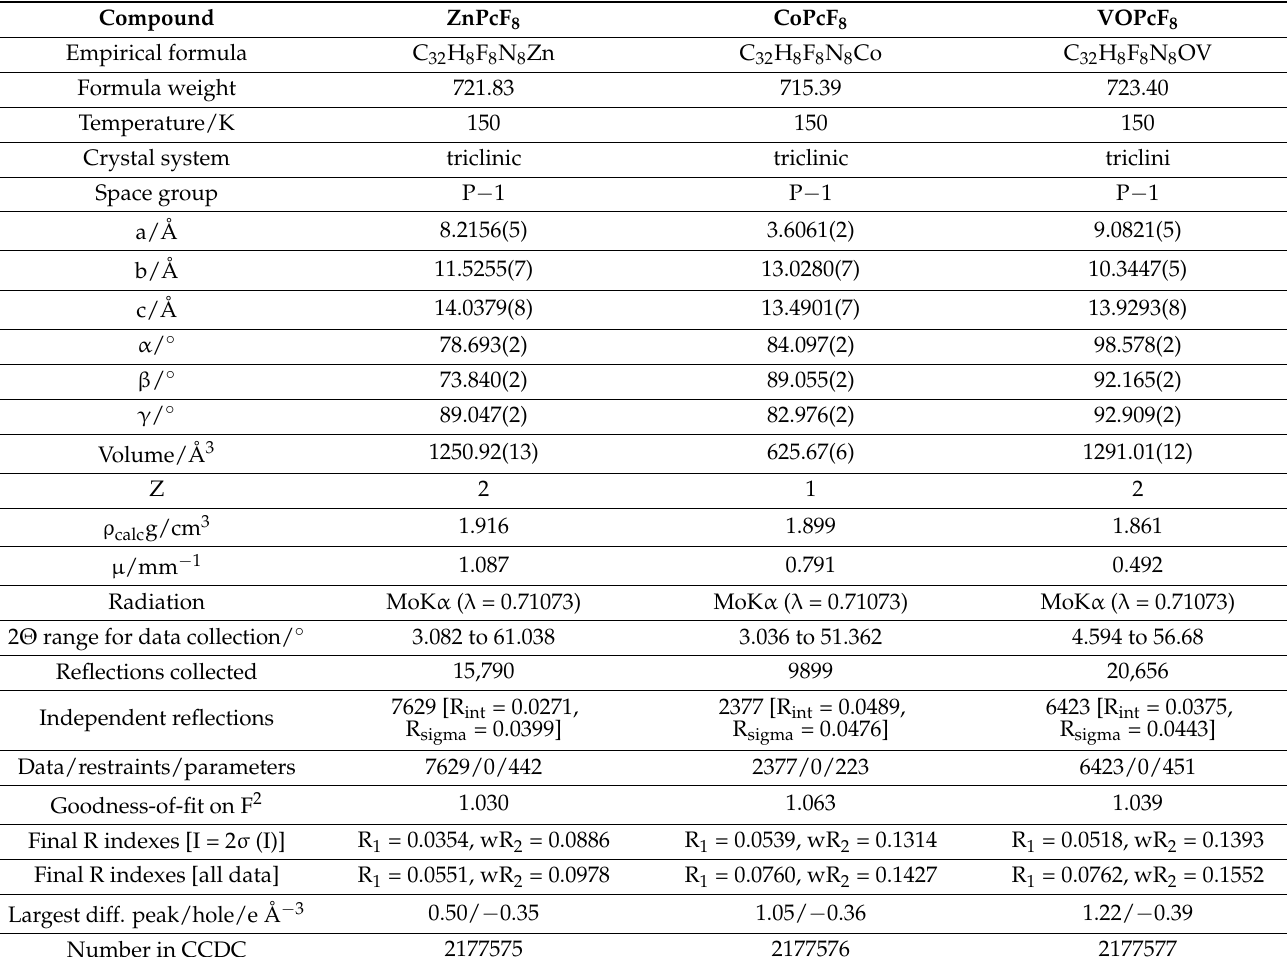
Table 1. Unit cell parameters and refinement statistics for MPcF 8 .